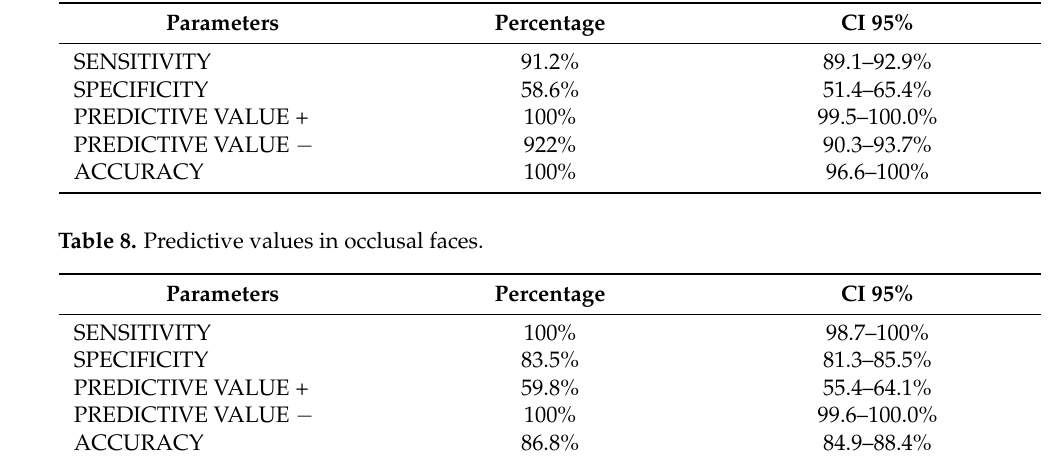
Table 7. Predictive values in lingual or palatal faces.